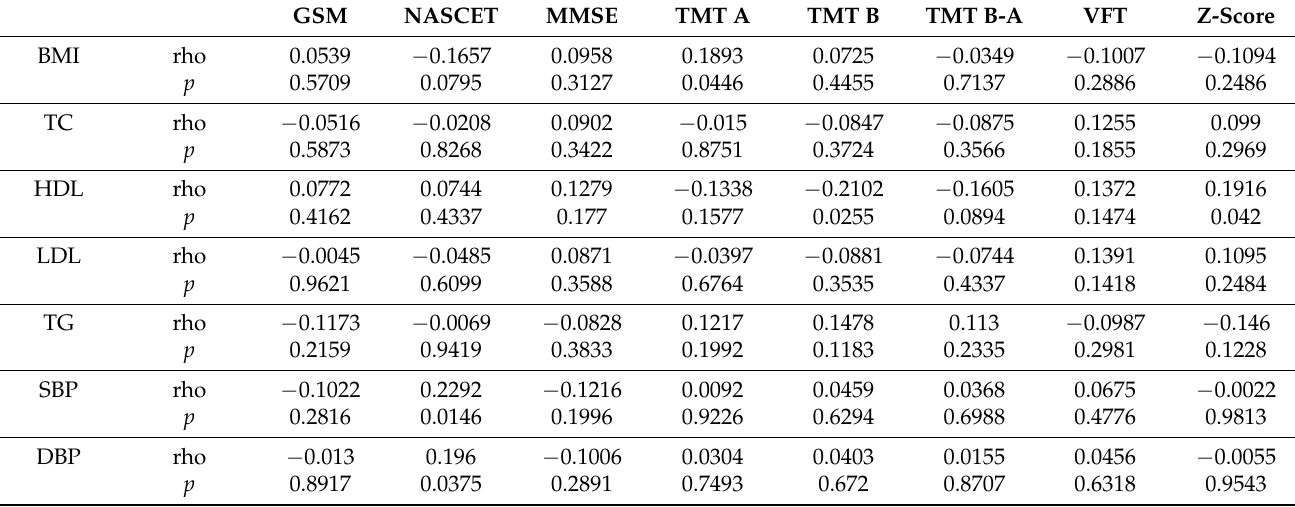
Table A1. Spearman correlations between the study variables at baseline.